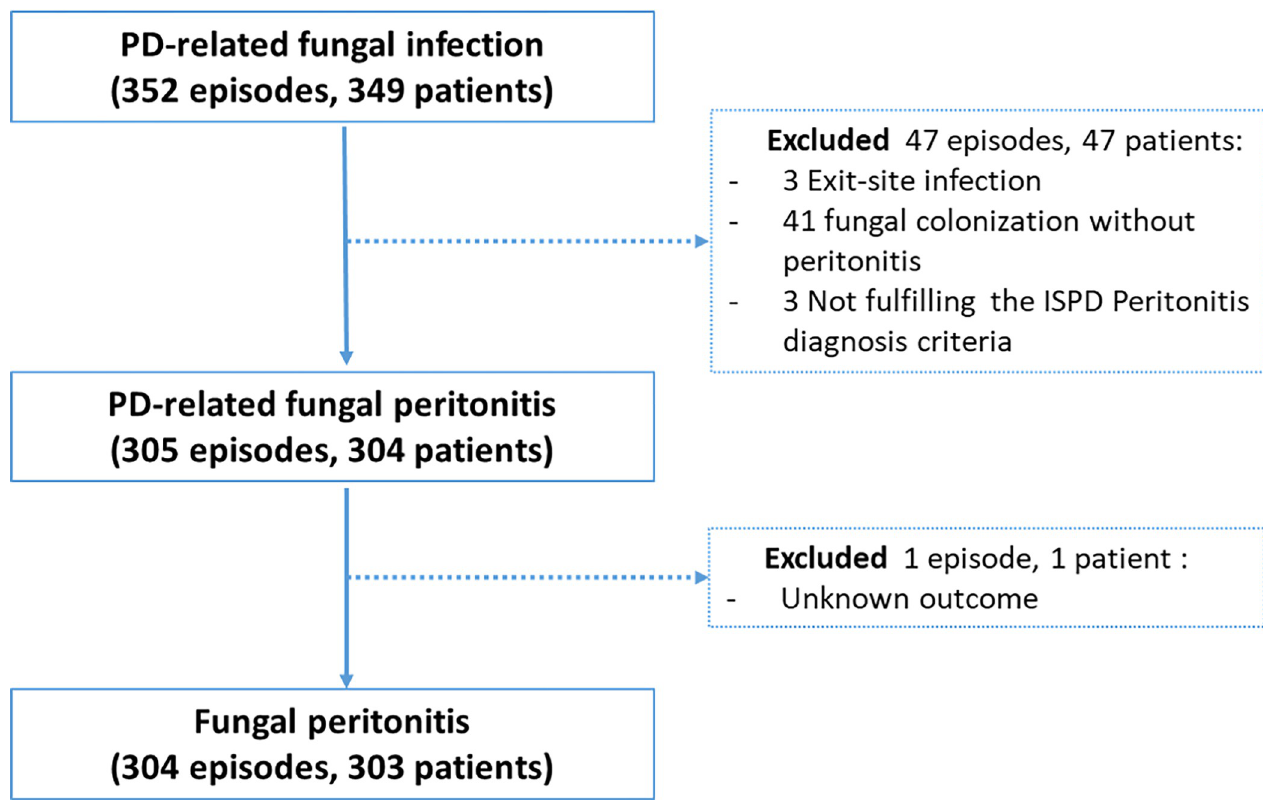
Fig 1. Patient flow